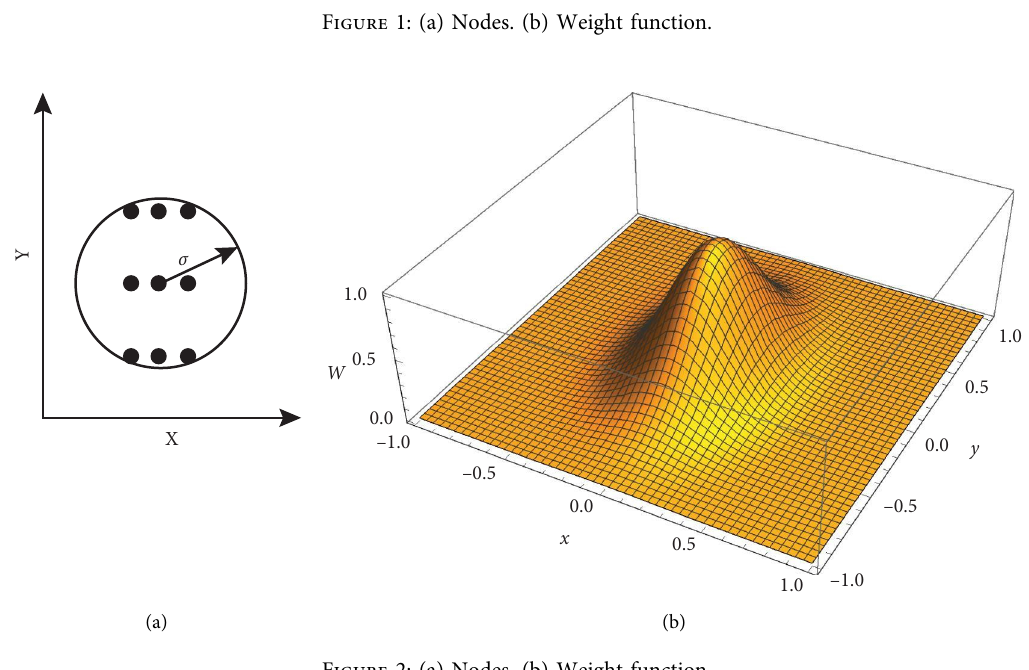
Figure 2: (a) Nodes. (b) Weight function.